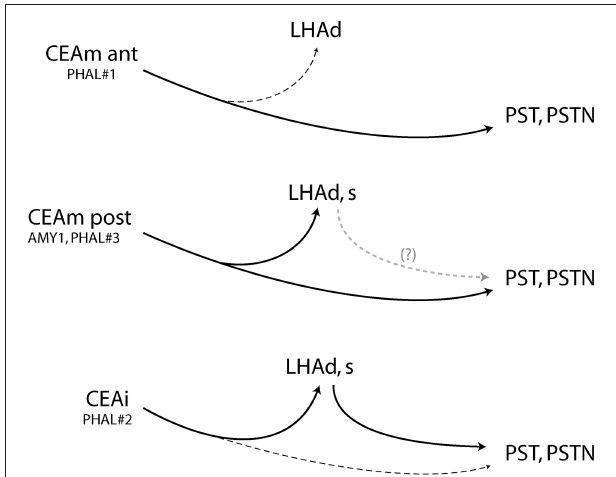
FIGURE 7 | Summary diagram and showing that the CEAm and CEAi send convergent projections into the posterior and lateral LHA but divergent projections into the LHAd, s. After CEAli injection, projections into the PSTN may require a relay into the perfornical LHA, suggesting an intra-LHA network under the control of the CEAi. It may also exist from the caudal CEAm but was not investigated in this study. (Dashed lines represent weak inputs).